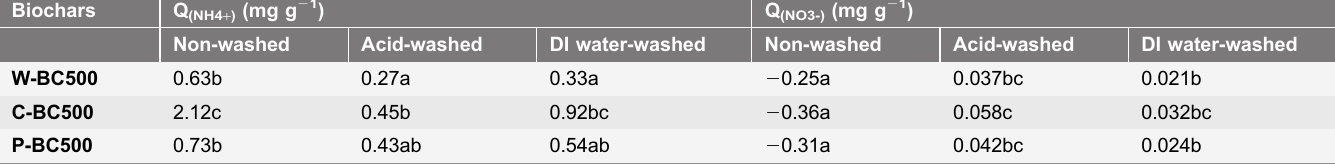
Note: Different letters indicate significant difference for the results and the adsorbed amounts of NH 4 + -N and NO 3 2 -N were compared separately.